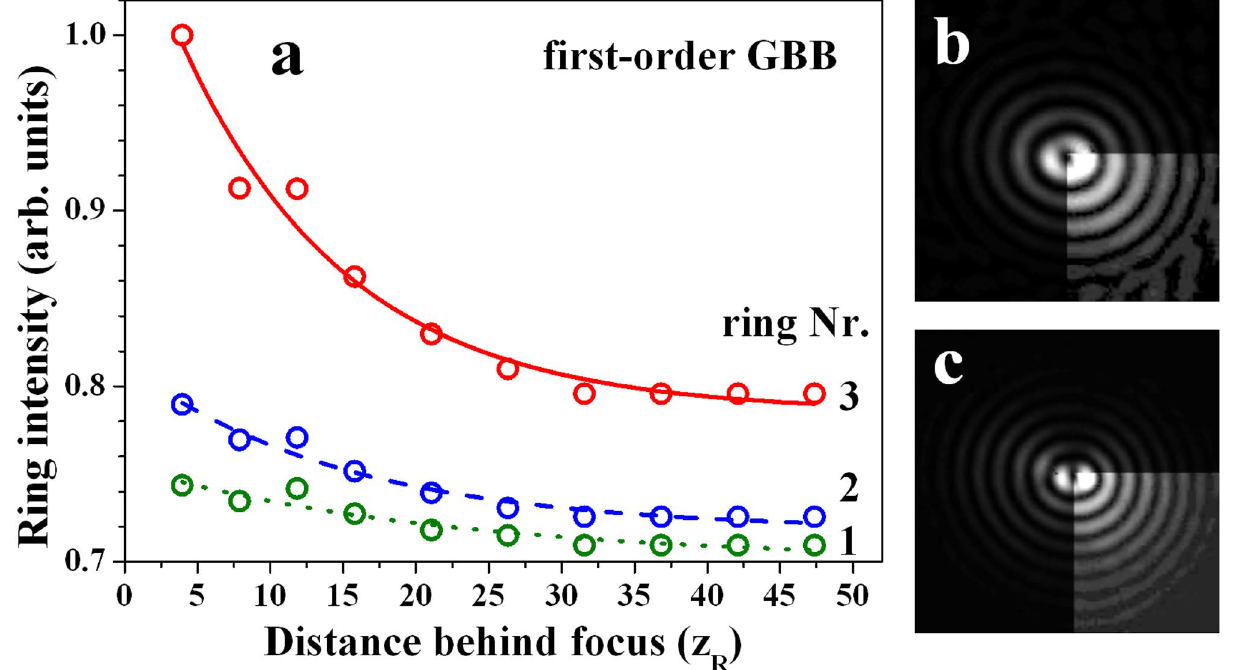
Figure 10. (a) Azimuthally-averaged peak intensity of the first three rings of the first-order GBB for r 0 /ω 0 = 21.4 (annihilating OVs with TC = 30, − 31 ). (b,c) first-order GBBs generated using TC = 20, − 21 and TC = 40, − 41 ( r 0 /ω 0 = 15.0 and 30.0, respectively), indicating that the number of unperturbed rings increases with r 0 /ω 0 and with | TC